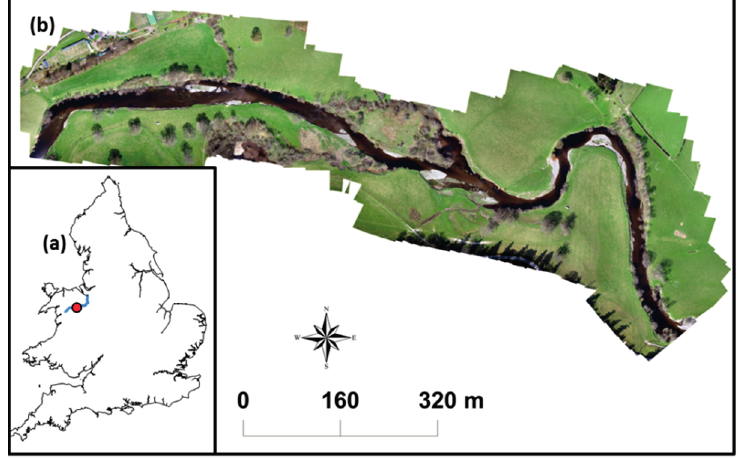
Figure 1. ( a ) Location of the study site along the river Dee near Bala, Wales,